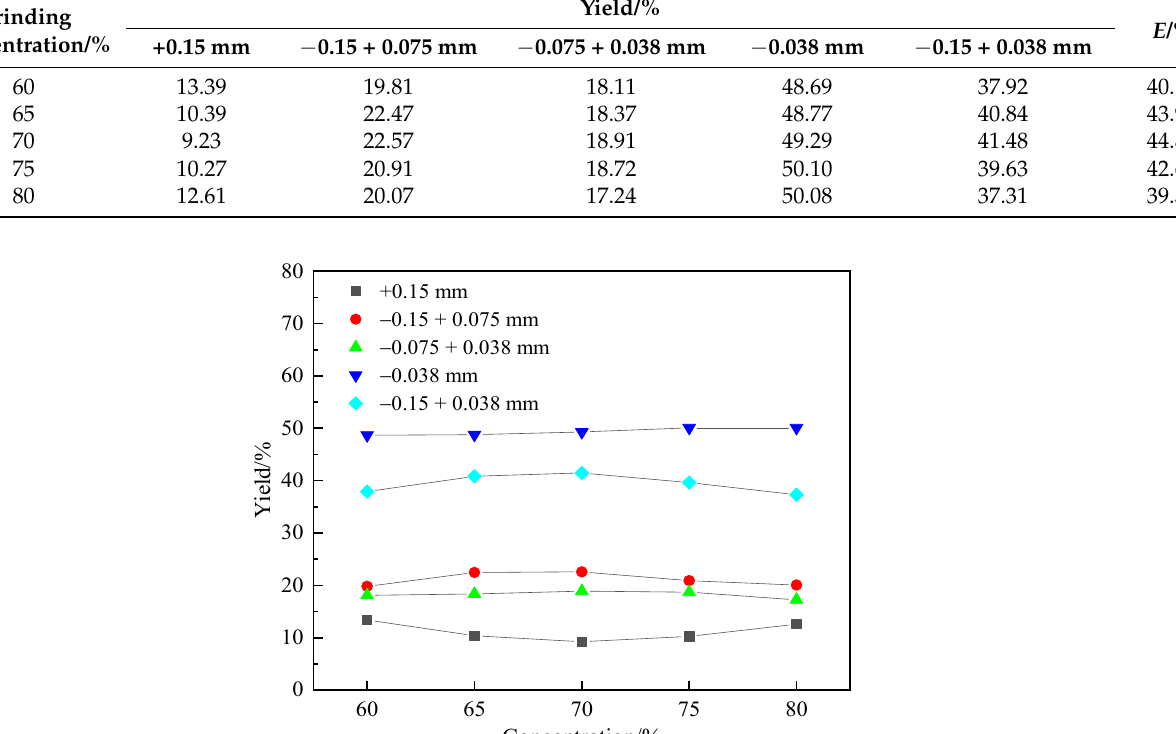
Table 5. Particle size composition of grinding product at different grinding concentrations.